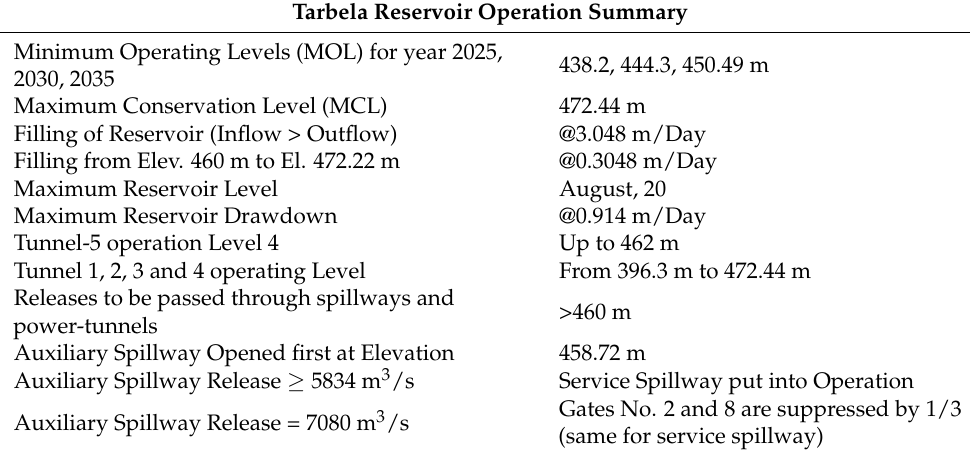
Table 5. Tarbela Reservoir Operation Set Summary